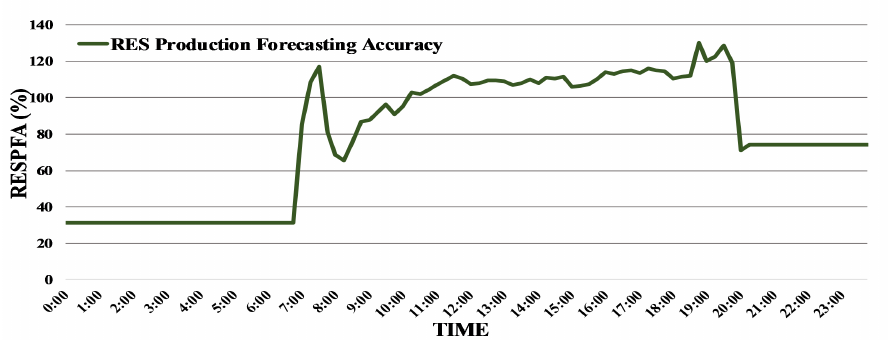
Figure 9. RES Production Forecasting Accuracy on the 23 August